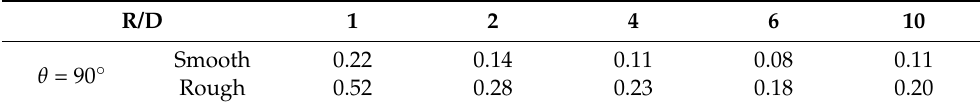
Table 3. Local drag coefficient of smoothing round bend.